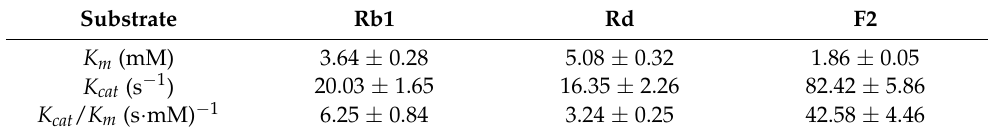
Table 2. Kinetic parameters of recombinant β -glucosidase SS-bgly for ginsenosides Rb1, Rd and F2. Substrate